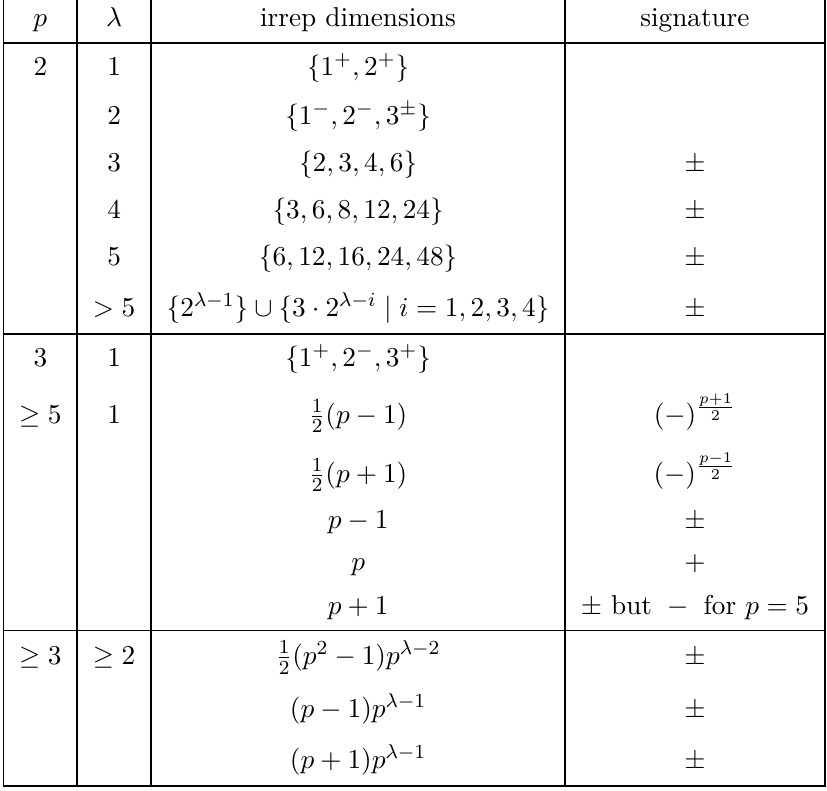
Table 1 . The dimensions and signatures of irreducible representations SL(2 , Z are not pullbacks of the irreducible representations SL(2 , Z map SL(2 , Z ) → SL(2 , Z ) p λ p λ − 1